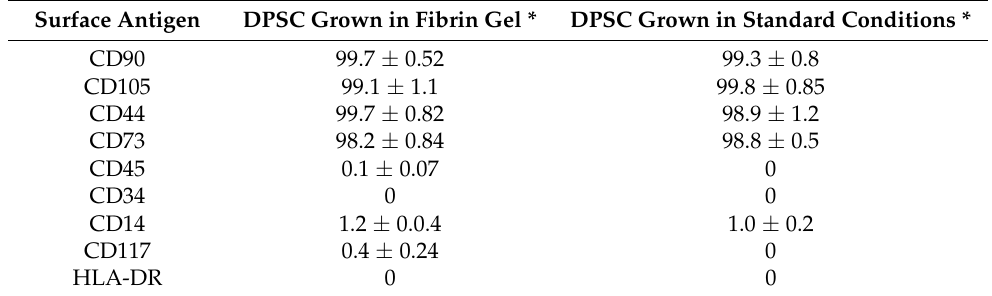
Table 1. Immunophenotype of DPSC embedded in fibrin glue and grown in standard conditions.